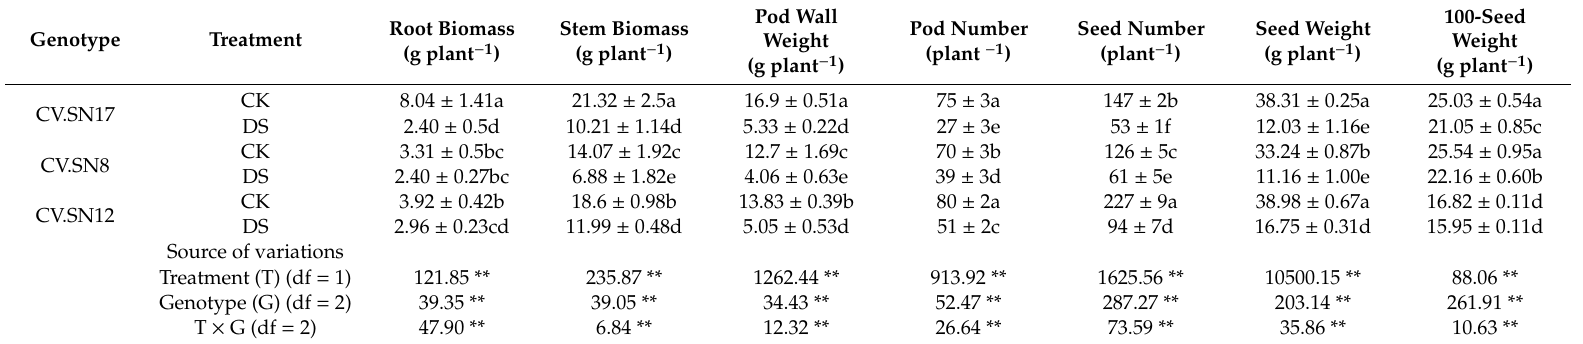
Table 2. E ff ect of drought stress on dry matter accumulation and seed yield.